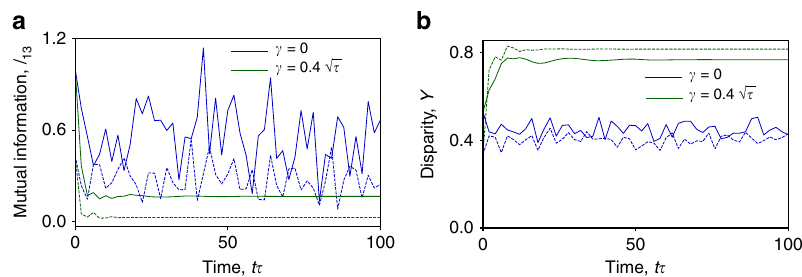
Fig. 4 Measures of complexity applied to the evolution of a random initial state of the open and closed Hubbard model. The data is for N = 3 particles on M = 4 sites (dotted lines) and N = 4 particles on M = 4 sites with the fi rst, second, and fourth sites being polarized along the x -direction and the third site along − x (solid lines). a The quantum mutual information between sites 1 and 3 that decreases quickly during the initial part of the evolution and is noticeably less for the open system case. b The average disparity Y between lattice sites growing with time for the open system dynamics and remaining approximately constant in the closed system. Other parameters as in